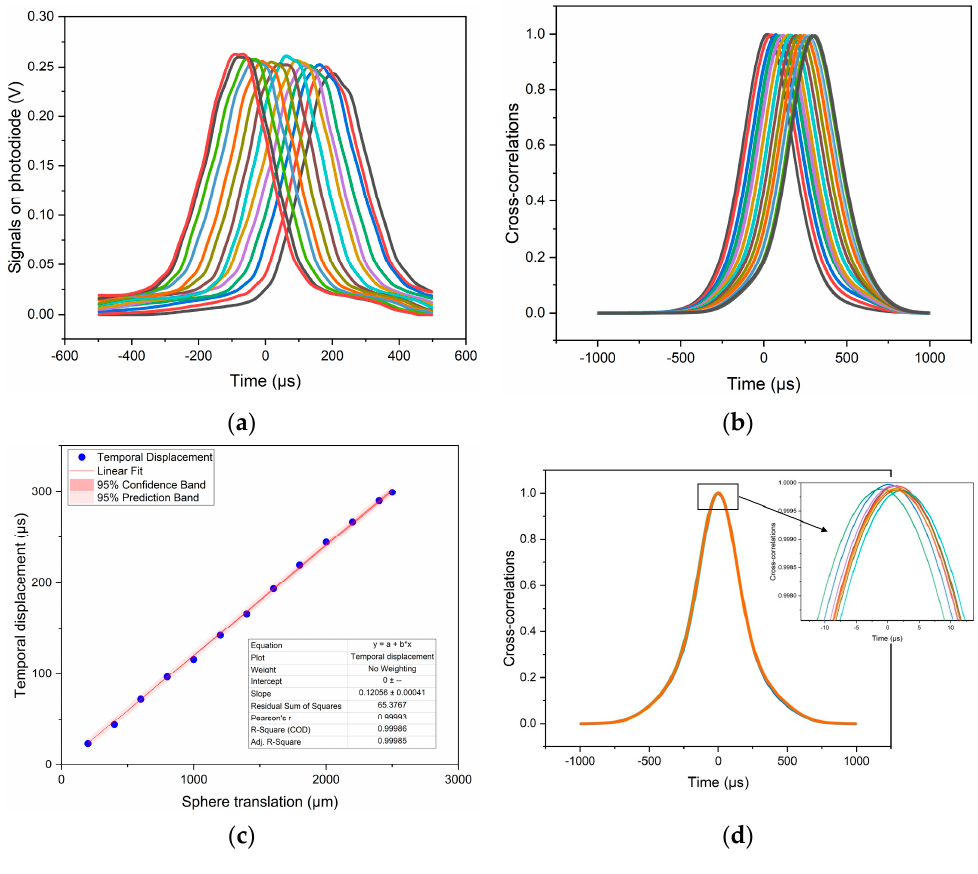
Figure 6. Evaluation of the resolution, rotating disc. Table 1. Results of the resolutions for the P1 prototype.